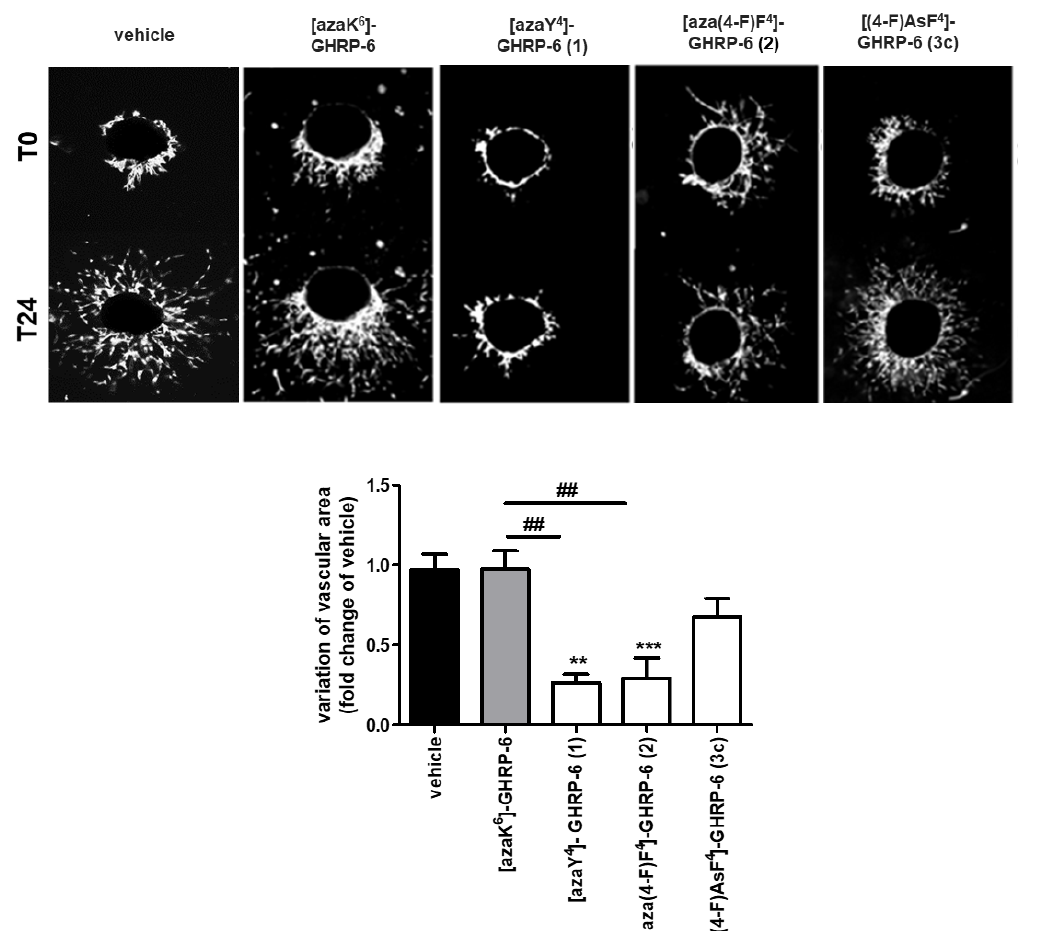
Figure 5. Angiogenic effects of [(4-F)AsF 4 ]-GHRP-6 ( 3c ), [azaY 4 ]- GHRP-6 ( 1 ) and [aza(4-F)F 4 ]-GHRP-6 ( 2 ) in a mouse choroidal explant model. Representative microvascular sprouting from Matrigel-embedded choroidal explants treated for 24 h with CD36 ligands (10 − 6 M). Histogram represents the quantification of the variation of choroidal sprouting areas according to the ratio (T24 − T0)/T0. Values are mean ± SEM ** P < 0.01, *** P < 0.001 compared to untreated (vehicle), ## P < 0.01 compared to [azaK 6 ]-GHRP-6 (negative control), n = 3–4.